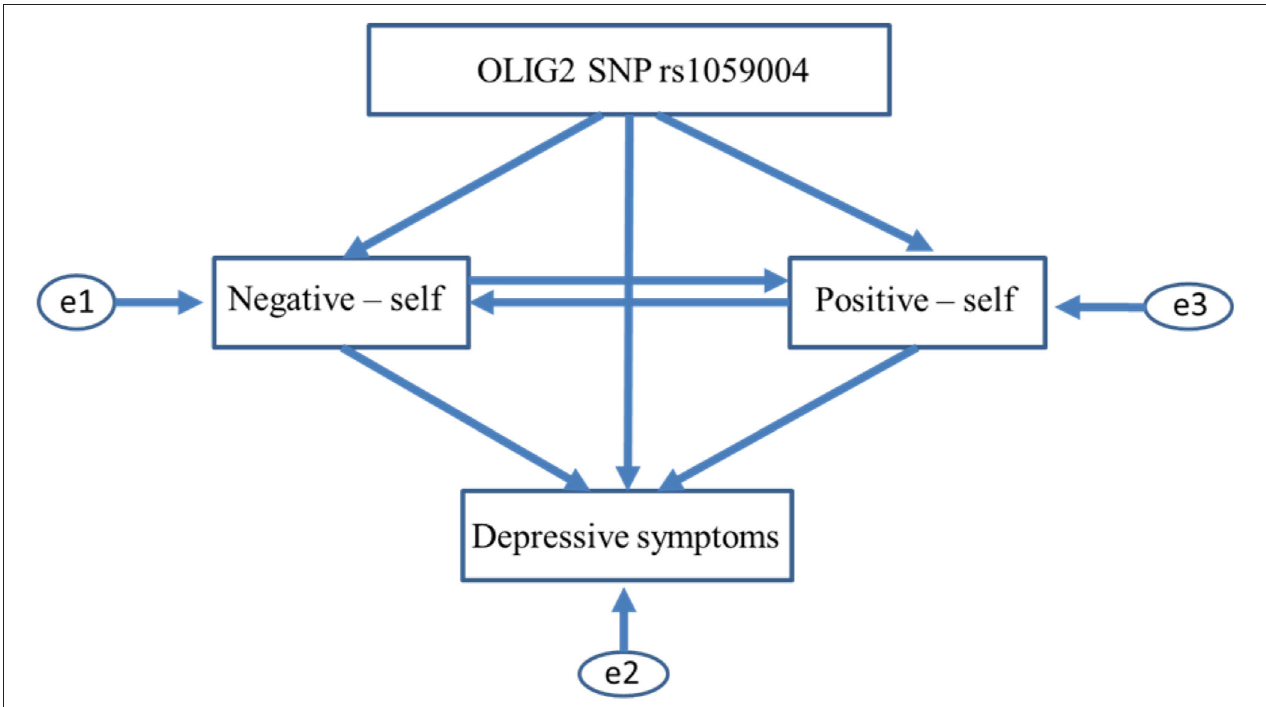
FIGURE 1 | Initial path models between OLIG2 gene SNP rs1059004, self-core schema, and depressive symptoms. The two initial path models (AIC = 20, CFI = 1, RMSEA = 0.363 in both models) shown in Figure 1 assume that OLIG2 SNP rs1059004 affects negative self-schema (negative self), positive self-schema (positive self), and depressive symptoms in one direction. In contrast, hypothetical paths were not created among each self-schema. SNP, single nucleotide polymorphism; AIC, Akaike information criterion; CFI, comparative fit index; RMSEA, root mean square error of approximation.